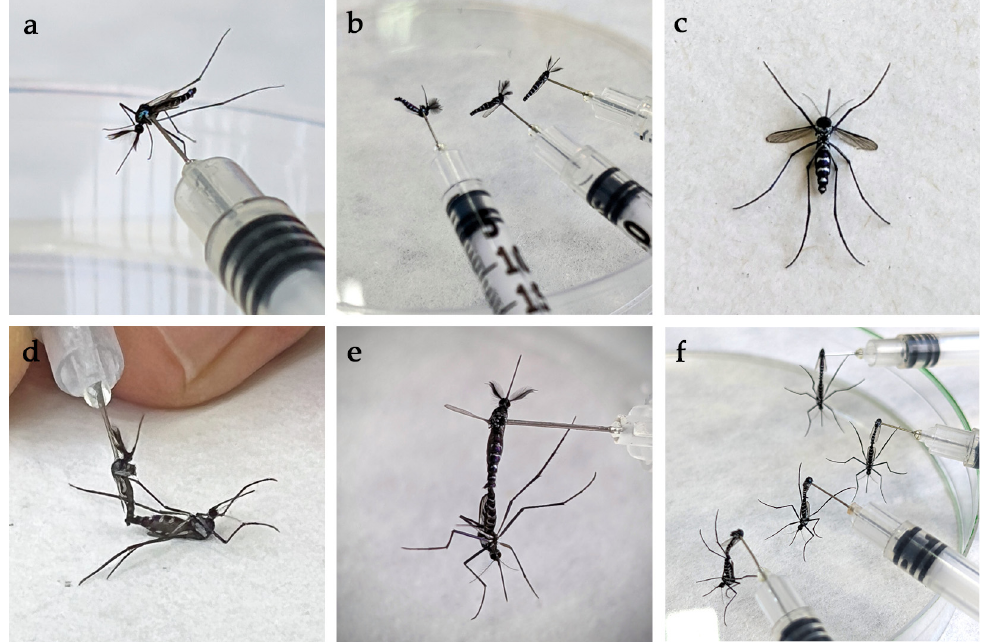
Figure 2. Forced mating F 1 generation Hg. janthinomys . ( a ) a male mosquito mounted laterally through the thorax on a 0.5 mL syringe; ( b ) mounted males with legs removed resting on a Petri dish; ( c ) a fully anesthetized female with legs relaxed; ( d ) introduction of mosquito terminalia at an angle of about 90 ◦ ; ( e ) fully interlocked male and female; and ( f ) decapitated male and female mating pairs at rest on the lid of a Petri